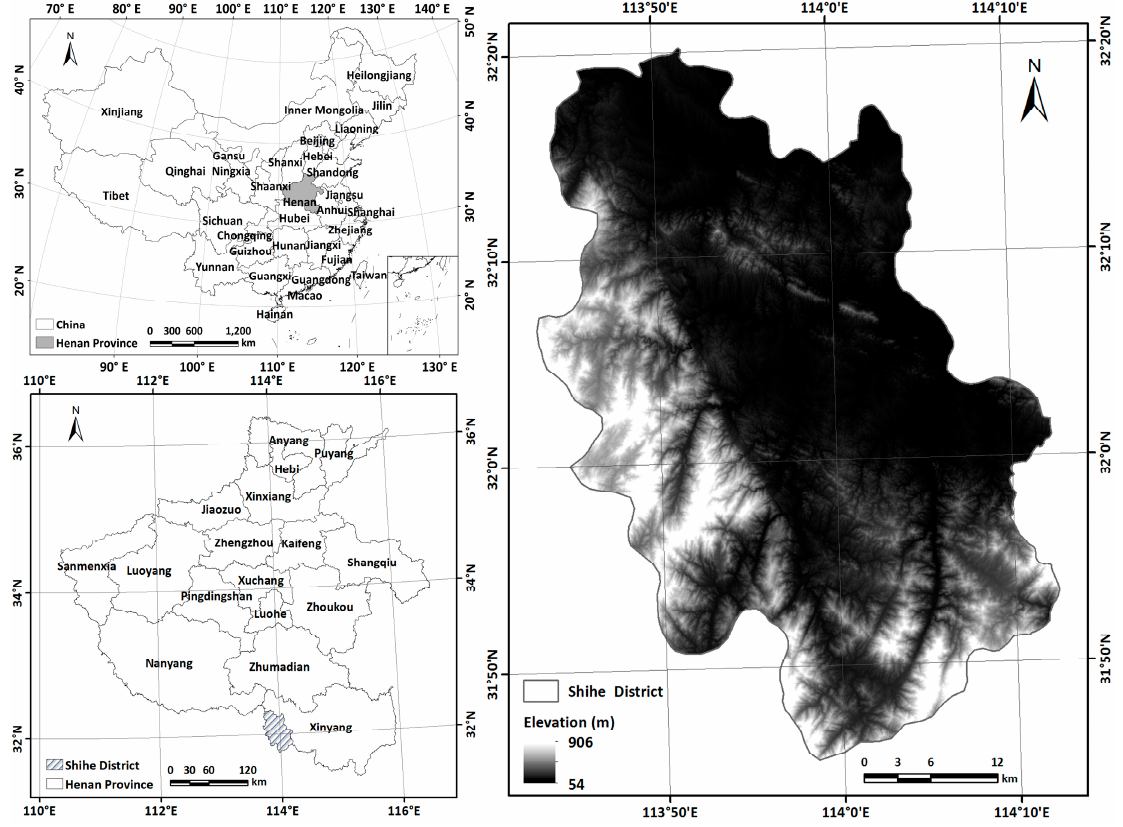
Figure 1. Study area location in Henan Province, China, and digital elevation model (DEM).